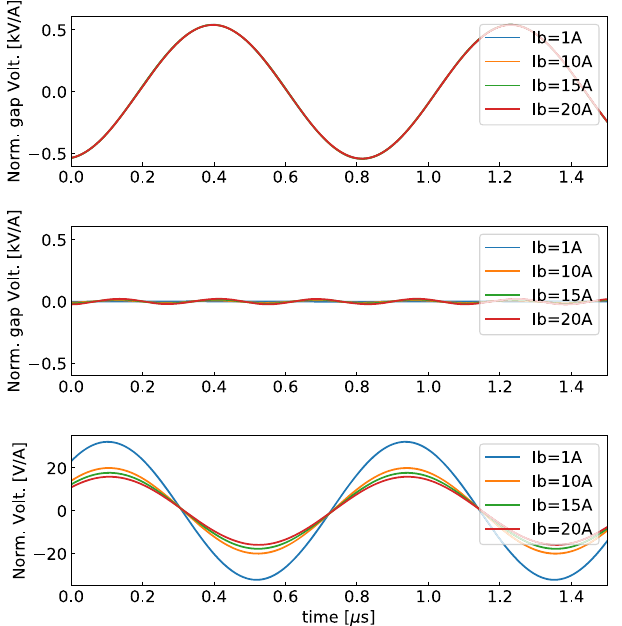
FIG. 3. (Top) Gap voltage waveforms normalized by the beam current without compensation, (middle) gap voltage waveforms normalized by the beam current with compensation by adjusting the amplitude and phase of the rf voltage source, and (bottom) normalized output waveform of the voltage source for compensation.